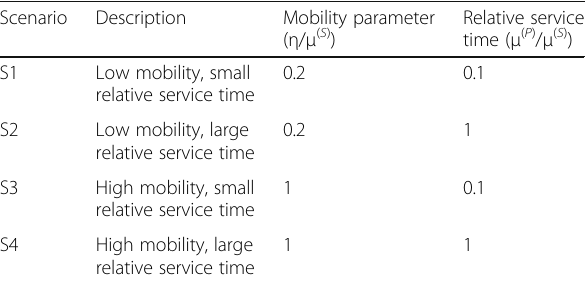
Table 6 Parameters for the considered scenarios Scenario